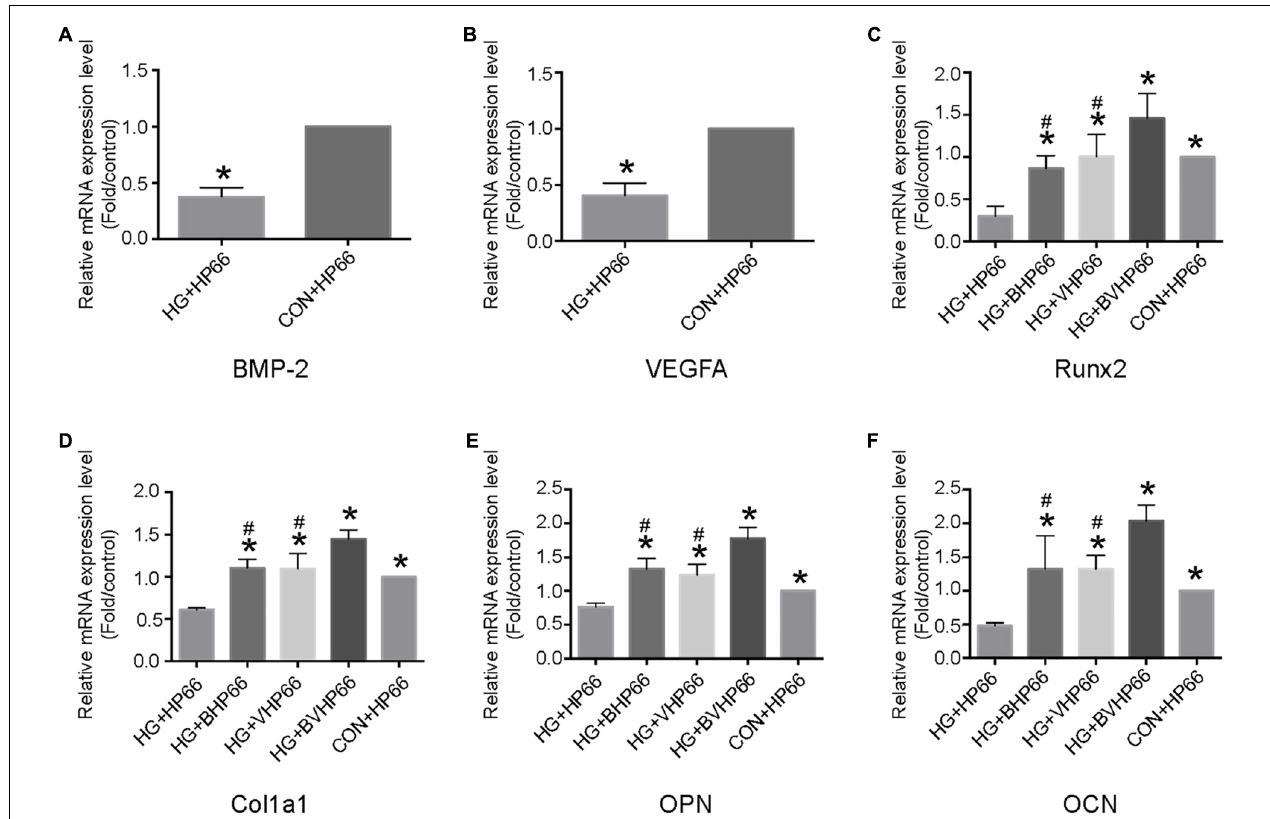
FIGURE 7 | Osteogenesis- and angiogenesis-related gene expressions of rBMSCs. Relative mRNA expression levels of (A) BMP-2 and (B) VEGFA in the HG + HP66 and CON + HP66 groups, (C) Runx2, (D) Cola1, (E) OPN, and (F) OCN in the HG + HP66, HG + BHP66, HG + VHP66, HG + BVHP66, and CON + HP66 groups. n = 3 for each group, data were expressed as mean ± SD. * P < 0.05, vs. HG + HP66 group; # P < 0.05, vs. HG + BVHP66